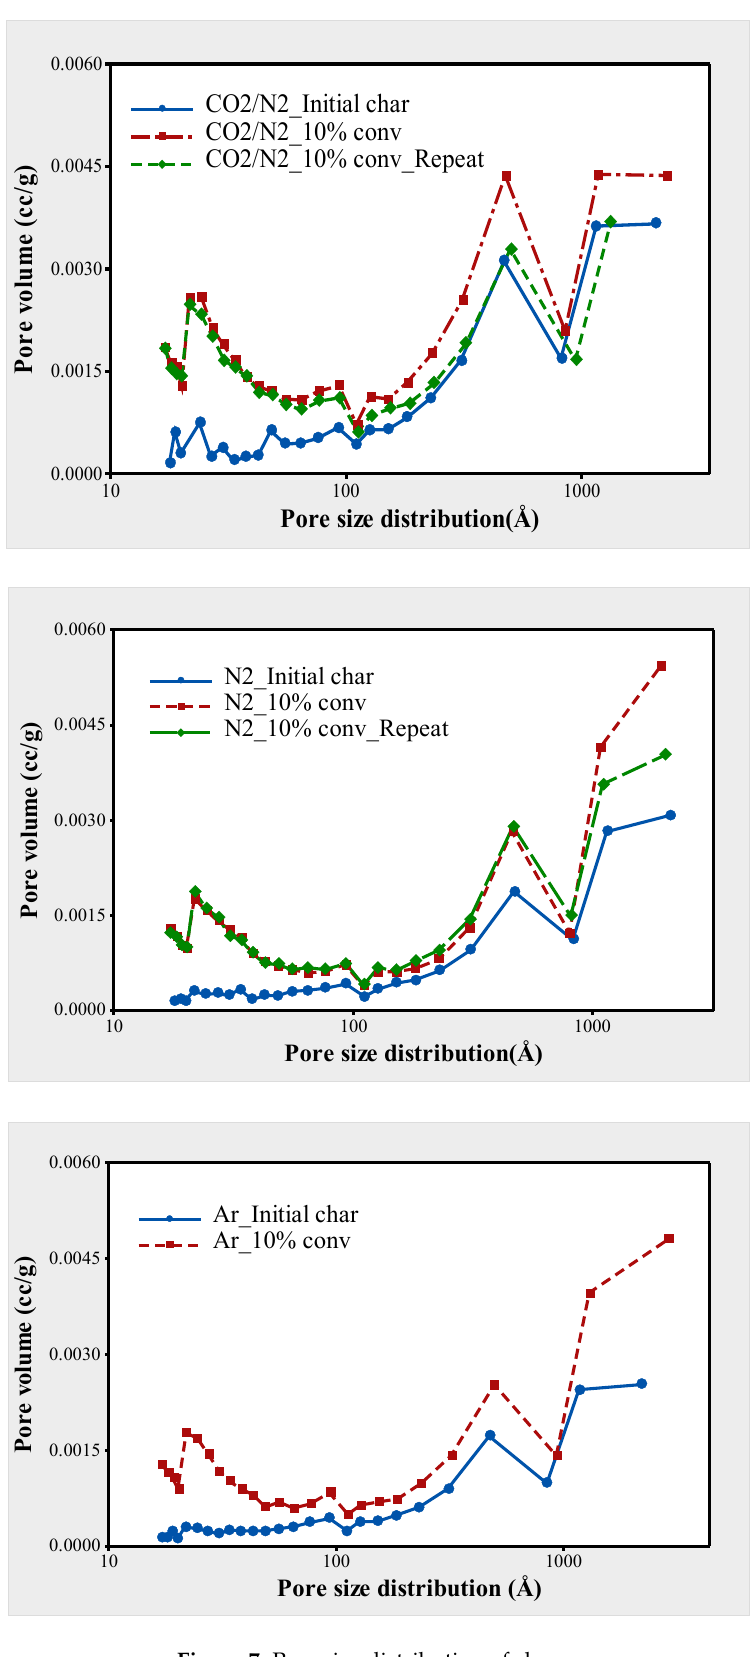
Figure 7 . Pore size distribution of chars. Figure 7. Pore size distribution of